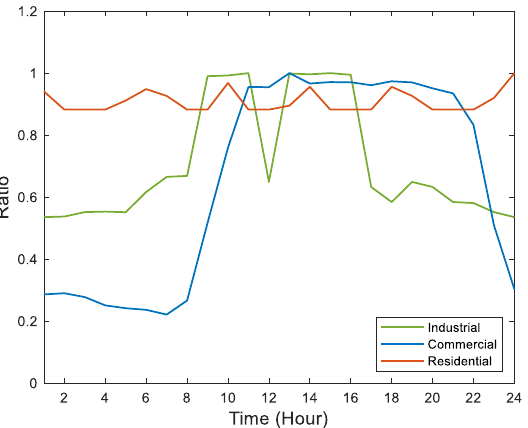
Figure 4. Normalized load profiles by customer types on a selected day.